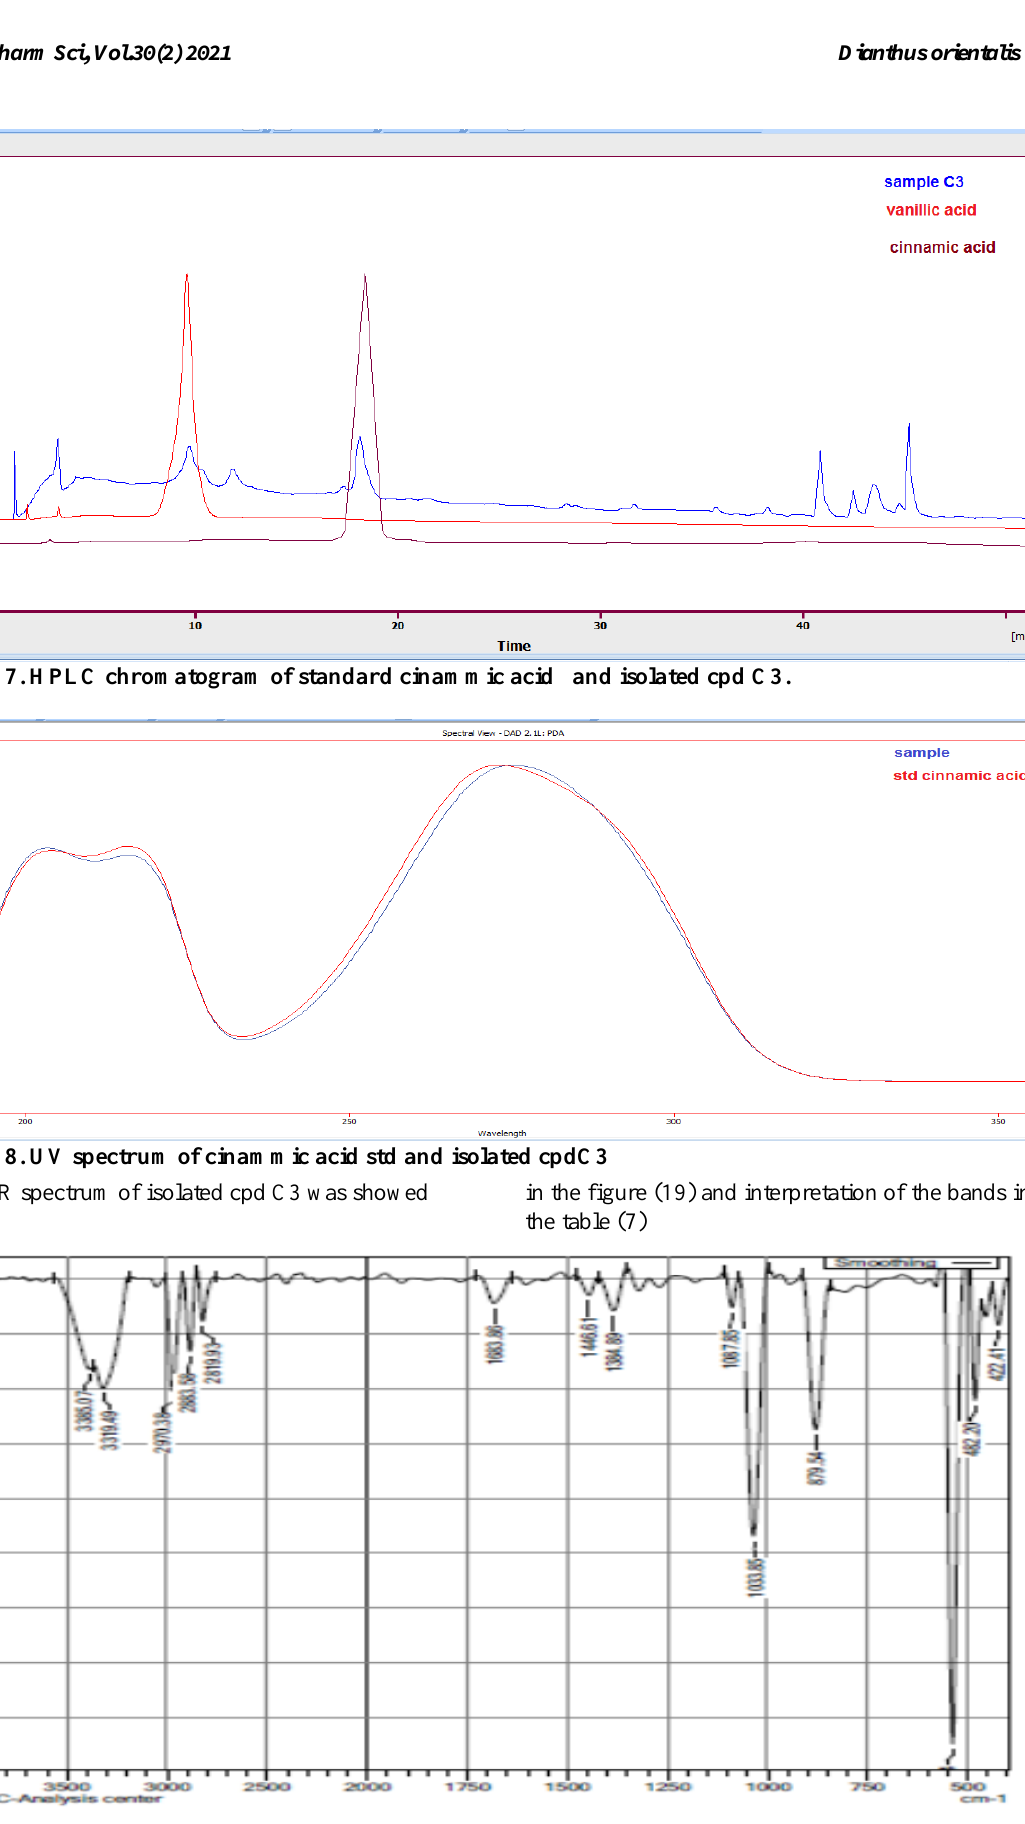
Figure 19.IR spectrum of isolated